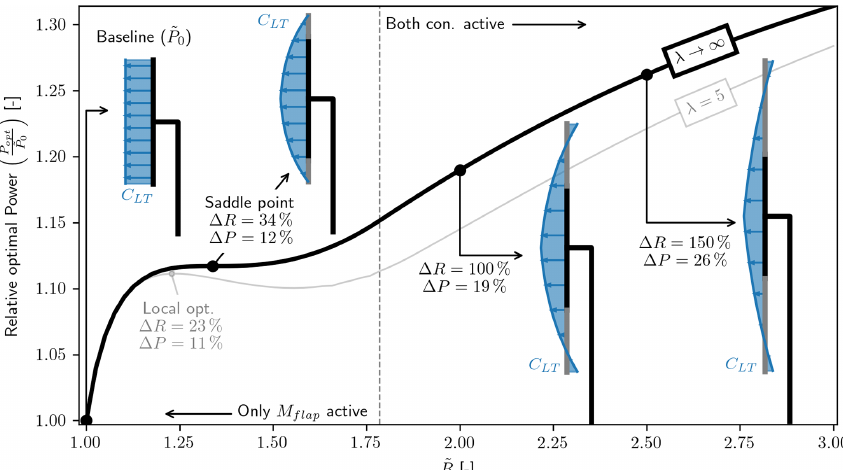
Figure 5. Optimal relative power ( ˜ P opt / ˜ P 0 ) for increasing radius. The global optimum is at ˜ R → ∞ . As expected the loading ( C LT ) is seen to taper towards the tip, and for large ˜ R the loading at the tip becomes